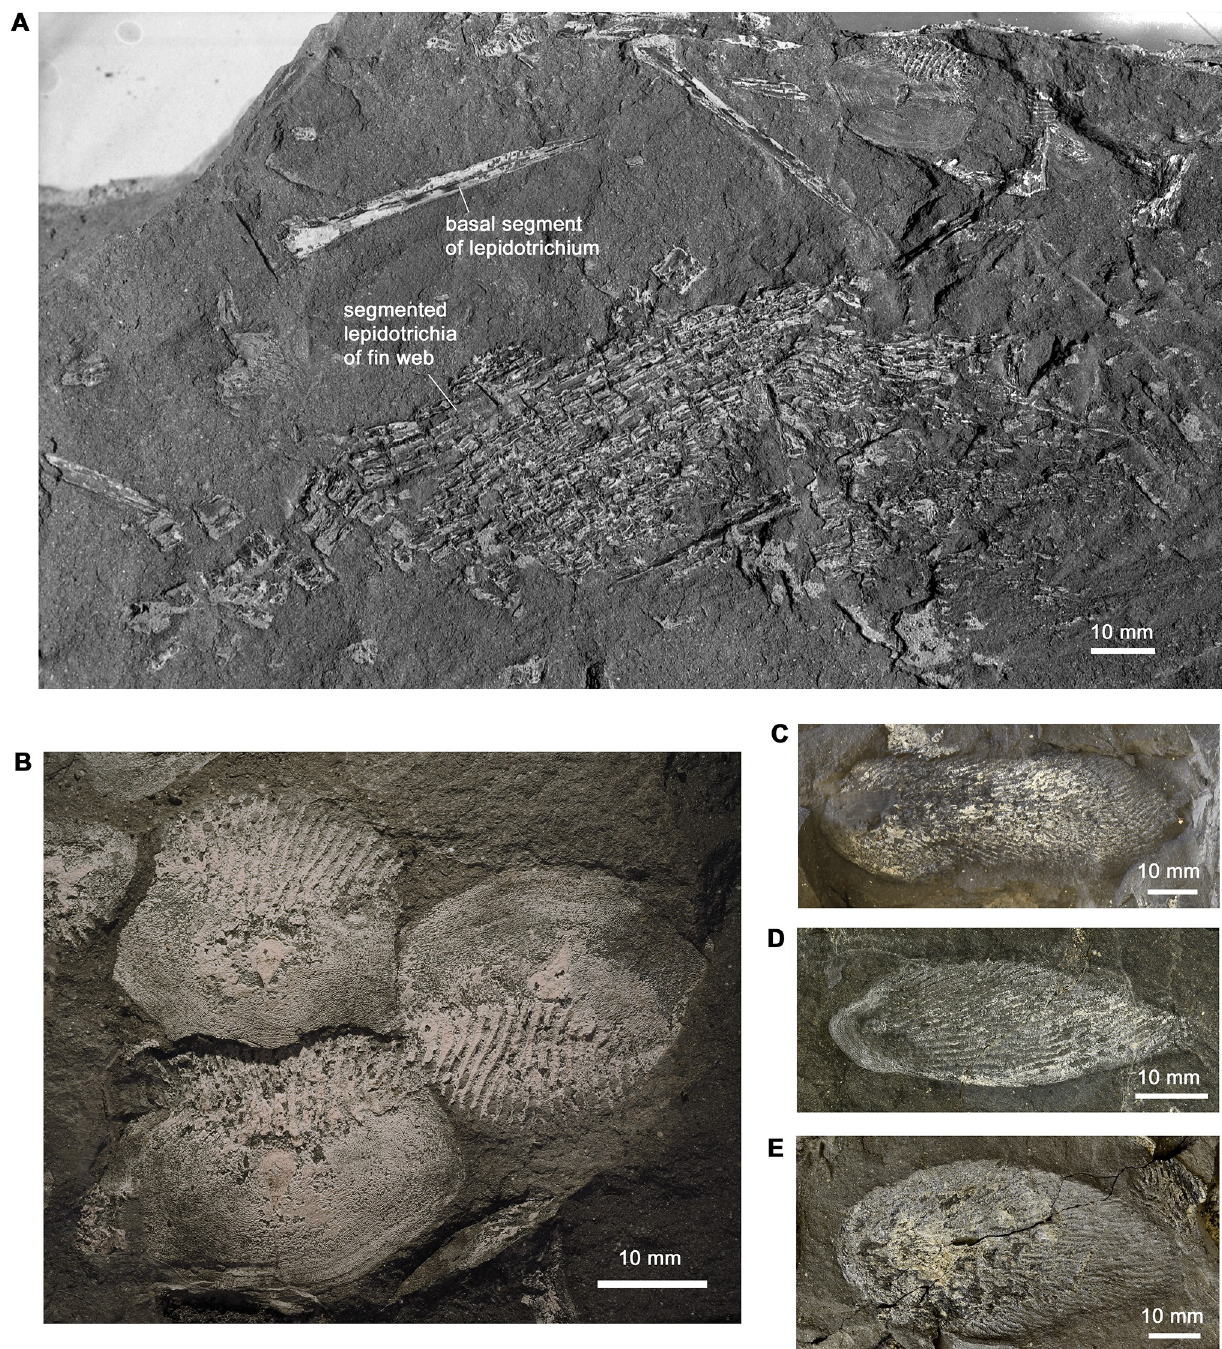
Fig 12. Lepidotrichia and scales. A, slab containing fin web fragment with articulated lepidotrichia, together with displaced basal segments of lepidotrichia and scales, AM5389ei. B, slab showing three typical body scales, AM18004. C-E, probable basal scutes of fins, C, AM6540. D, AM5389. E,